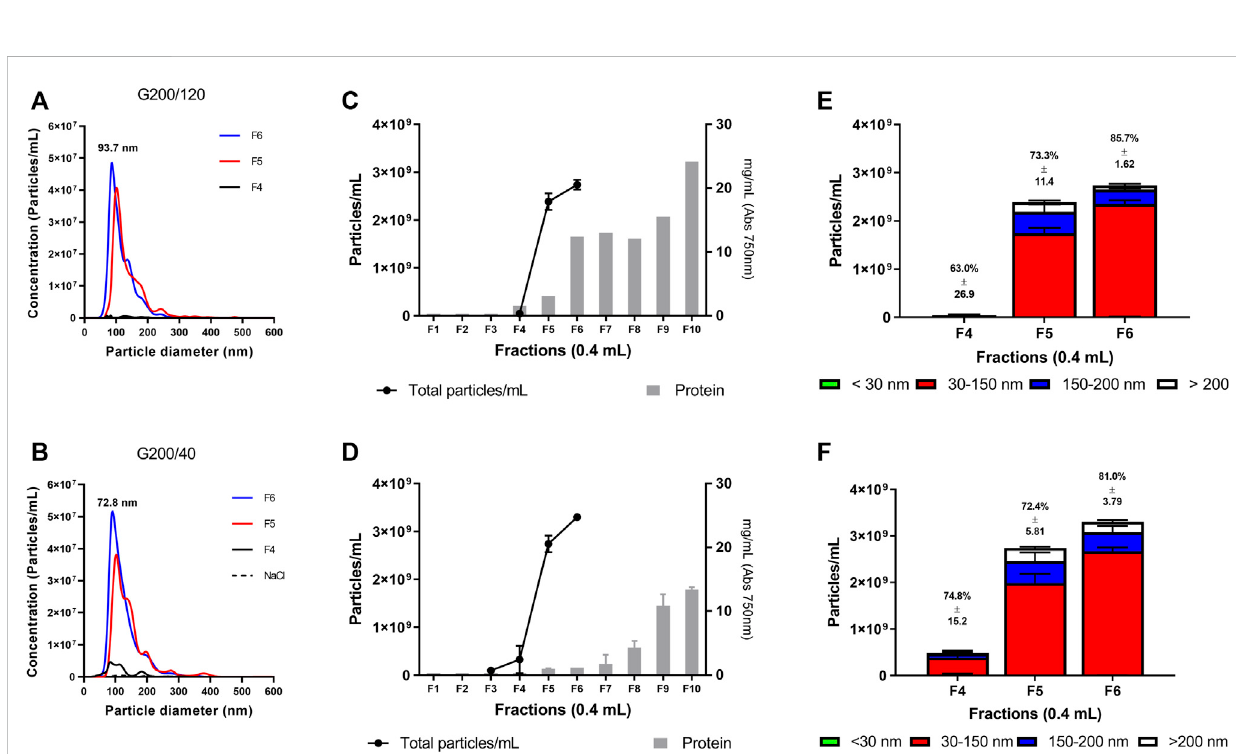
FIGURE 3 Nanoparticletrackinganalysis offractions fromEVcollectionmedium:ColumnsG200/120andG200/40,20plates,and400 µLofvolumefraction. (A, B) representative NTA of small EVs isolated from cell media with G200/120 (A) and G200/40 (B) column. (C , D) particle and protein distribution in the collected fractions. (E, F) size distribution of the isolated EVs. The percentage over each column represents the fraction of 30 – 150 nm vesicles. NTA indicates Nanoparticle tracking analysis. Bar colors represent the subpopulation of EVs isolated in terms of size. n = 6 for each column.